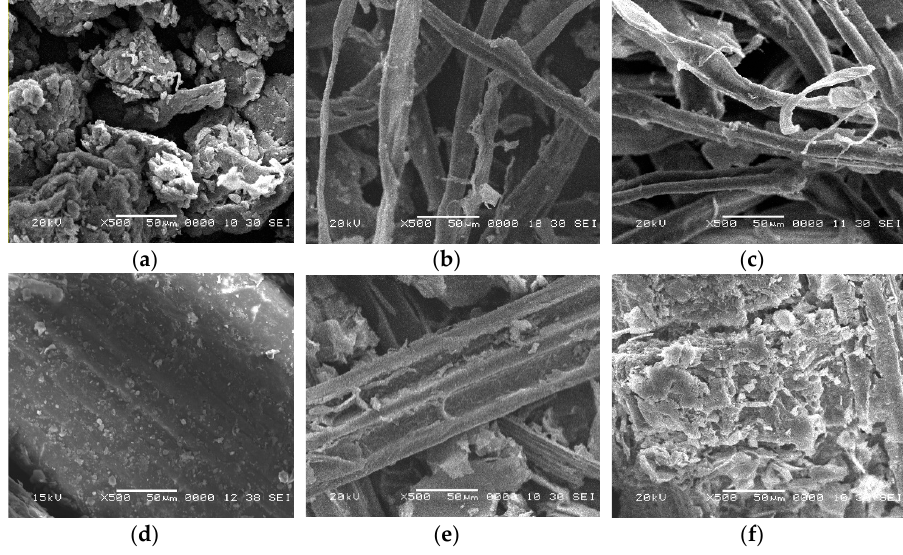
Figure 4. SEM images of ( a ) TP, ( b ) TPZ, ( c ) TPNZ, ( d ) CS, ( e ) CSZ, and ( f )